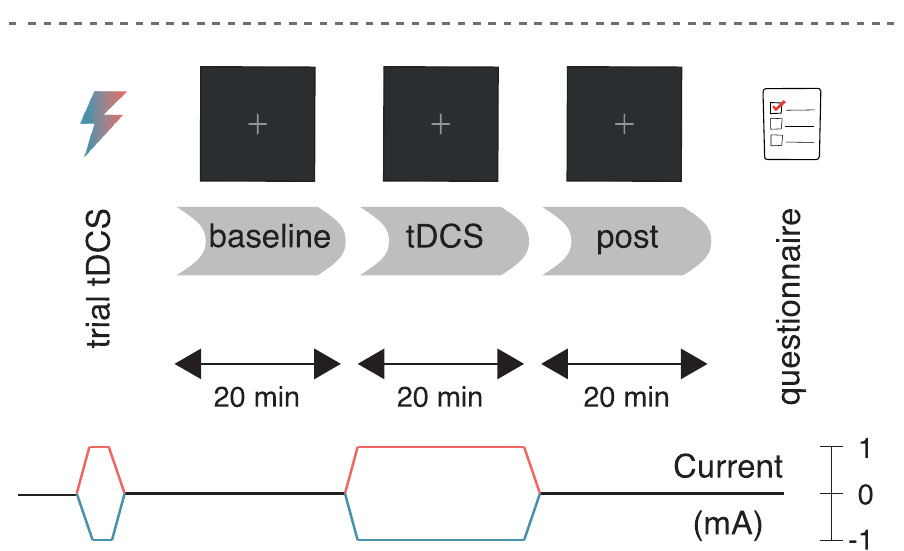
Fig 1. Experimental design. After a baseline block without stimulation, participants performed the attentional blink task during 20 minutes of anodal (red) or cathodal (blue) tDCS, followed by a post-test block (also